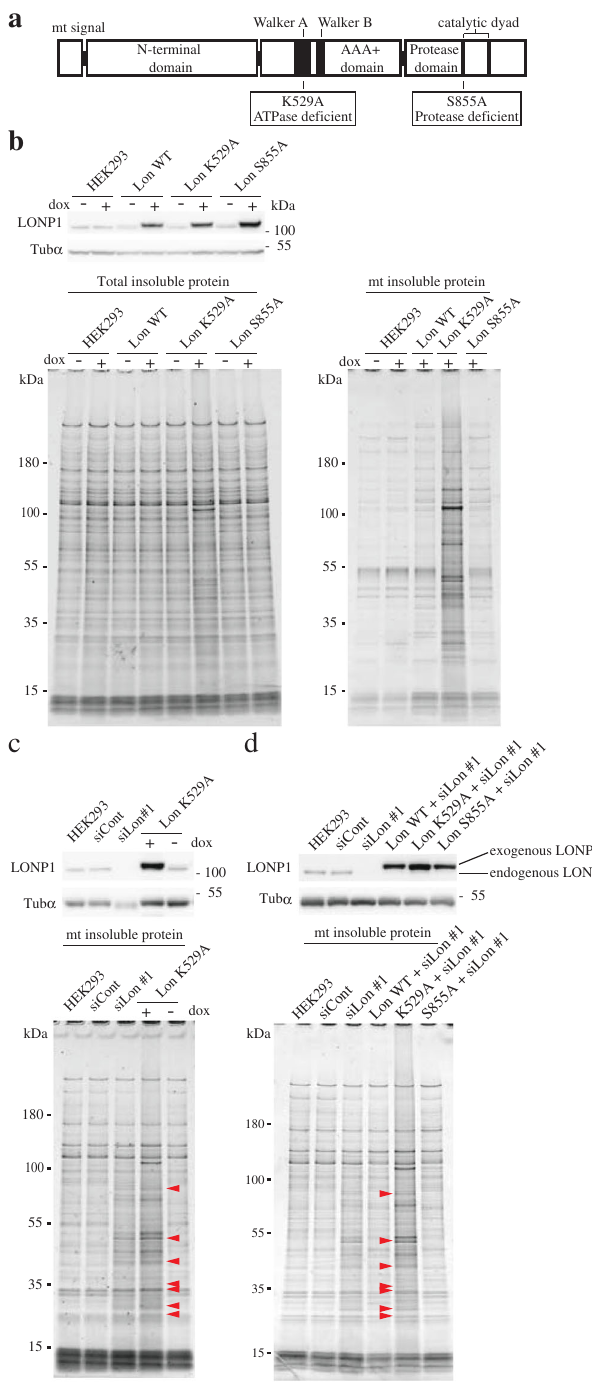
of TFAM degradation following ethidium bromide treatment (which causes mtDNA depletion in cells) (Supplementary Fig. S6c). These results indicate that both LONP1 mutants exhibit a domi- nant negative phenotype, which is caused by the formation of mixed oligomeric forms, composed of the mutants and endogen- ous LONP1. After 6 d of induction in the presence of Dox, the cell line expressing LONP1 K529A accumulated insoluble proteins in mitochondria identical to that observed for LONP1 knockdown cells (Fig. 4b, c and Supplementary Fig. S7a). Similar results were obtained using HEK293 cell line expressing Walker B mutant LONP1, E591A (Supplementary Fig. S7b). Surprisingly, in the cell line expressing S855A, the insoluble mitochondrial proteins did not change when compared with that of the control cells (Fig. 4b, c and Supplementary Fig. S7a). To exclude the possibility that endo- genous LONP1 affects mitochondrial protein aggregation in cells expressing LONP1 S855A, we selectively knocked down endo- genous LONP1 in HEK293 cells expressing the LONP1 mutants (Supplementary Fig. S6b). The knockdown process was repeated twice at 3-d intervals and the cells were harvested 6 d after the fi rst transfection. Even when endogenous LONP1 was depleted, the speci fi c insoluble proteins associated with LONP1 knockdown were scarcely detectable in cells expressing the LONP1 S855A mutant (Fig. 4d). These results indicate that loss of the protease function in LONP1 is not critical for the accumulation of speci fi c insoluble proteins, and that the LONP1 S885A mutant retains activity that prevents protein aggregation associated with endo- genous LONP1 depletion. In contrast, the cell line expressing LONP1 K529A exhibited accumulation of the speci fi c insoluble proteins associated with LONP1 knockdown, with or without endogenous LONP1 knockdown. These results reveal that the ATPase activity of LONP1 is essential for the solubilization of the speci fi c proteins. Since the ATPase activity is essential for chaperone-like activity in the yeast Lon protease 25 , chaperone-like activity of LONP1 toward proteins newly imported into the matrix may be important for suppression of aggregation.